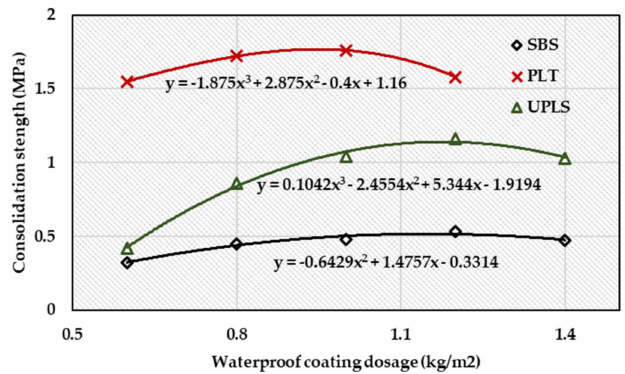
Figure 15. Consolidation strengths of the three waterproof coatings with di ff erent